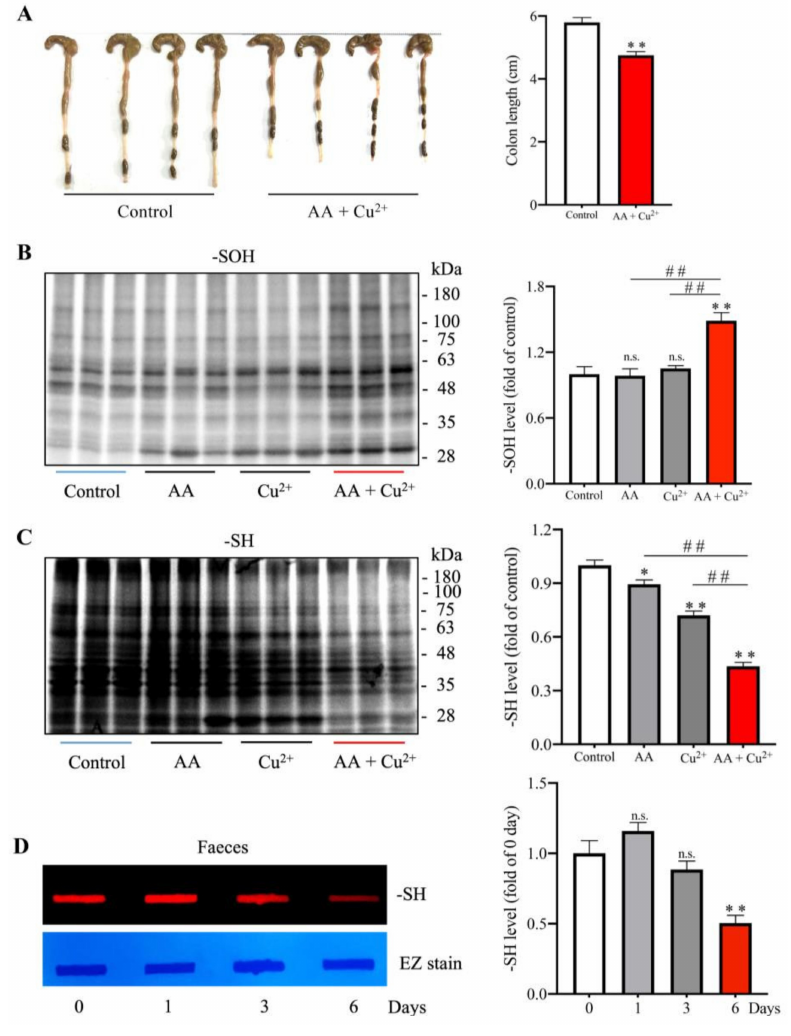
Figure 2. Effects of in vivo administration of AA and Cu 2+ on colon length and oxidation. ( A ) Effects of combined administration on colon length. Mice were administered 100 mg/kg AA or 1 mg/kg Cu 2+ in combination via oral gavage once a day for 6 days. The colon was taken, photographed ( A ), and measured for length. The results shown on the right side of the photo are mean ± SE ( n = 4–6; ** p < 0.01 vs. control). ( B , C ) Effects of AA plus Cu 2+ on the oxidative modification of -SH groups in colon proteins. Mice were administered with 100 mg/kg AA or 1 mg/kg Cu 2+ or both in combination via oral gavage once a day for five consecutive days. The level of -SH groups and -SOH formation in colon lysates were detected. The quantitation of the bands was performed, and data are shown in the bar graph below the blot. Data shown are mean ± SE ( n = 3–4; n.s.: not significant; * p < 0.05; ** p < 0.01 vs. control; ## p < 0.01). ( D ) Effects of AA plus Cu 2+ administration on the level of -SH groups in feces. Proteins from feces were subjected to Dot blot analysis for the level of -SH groups using a maleimide-labeling assay. The result of the densitometric analysis of the bands is shown at the right side of the blot. Data shown are mean ± SE ( n = 3, n.s.; ** p < 0.01 vs.